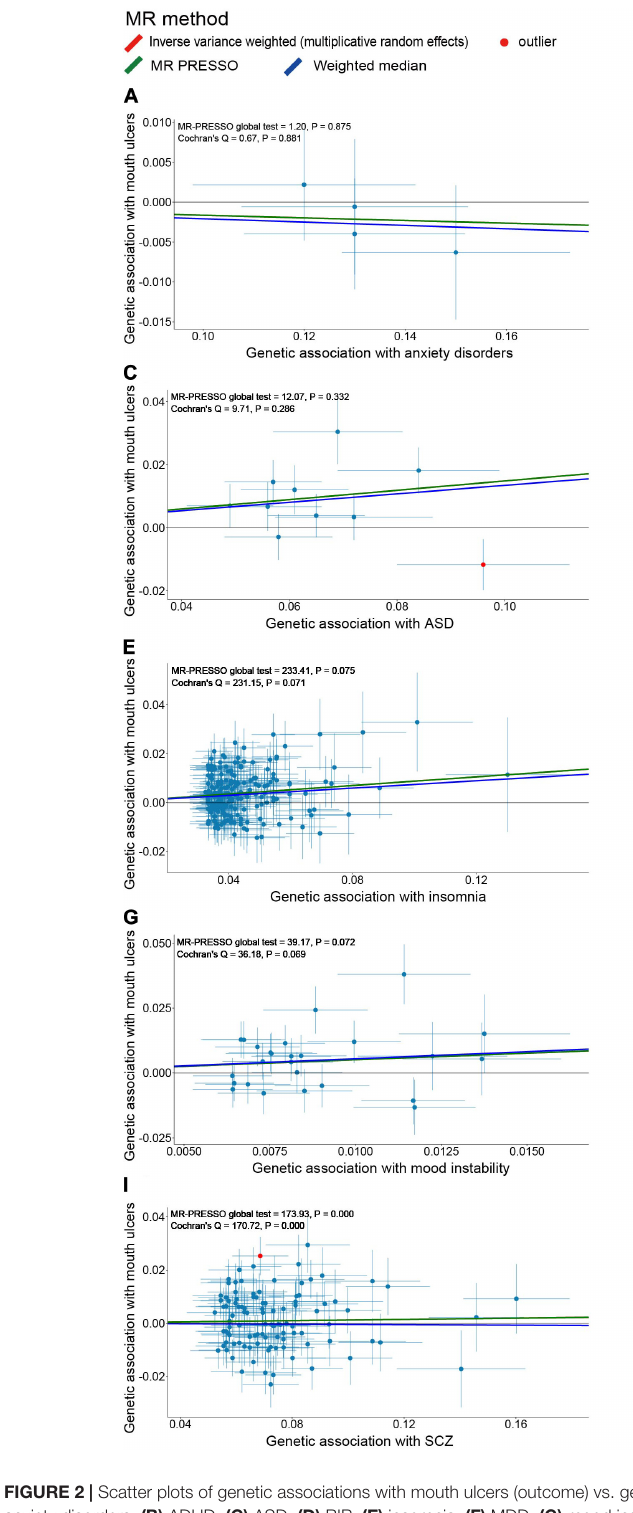
Frontiers in Genetics |